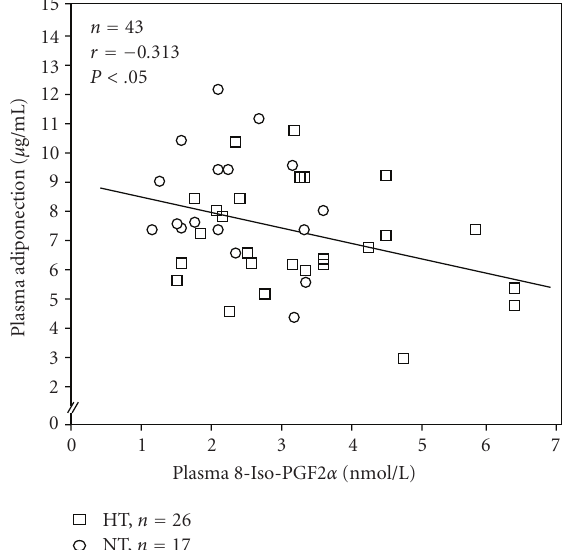
Figure 6: Inverse correlation between plasma adiponectin levels and the order parameter ( S ) of red blood cells (RBCs) in hyper- tensive and normotensive